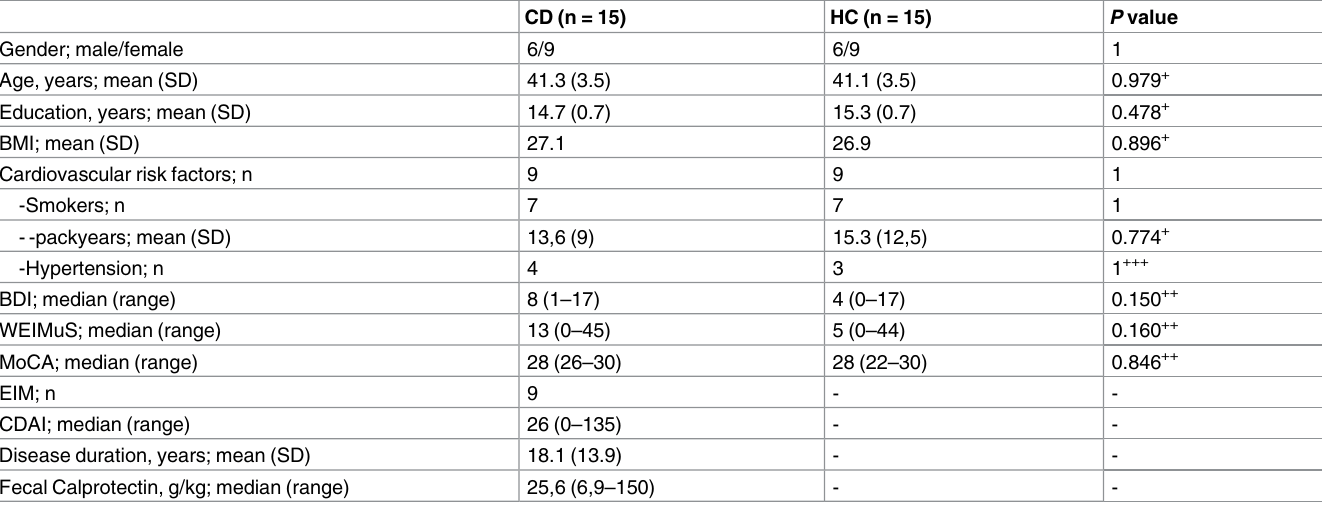
Table 1. Demographics and clinical characteristics of CD patients and